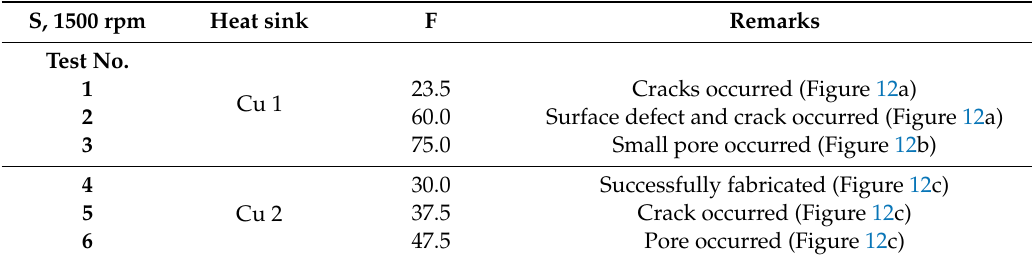
Table 10. Experiments to fabricate dissimilar Cu-2219 Al lap joint with WC square-tool using heat sink (T D : 20 s).